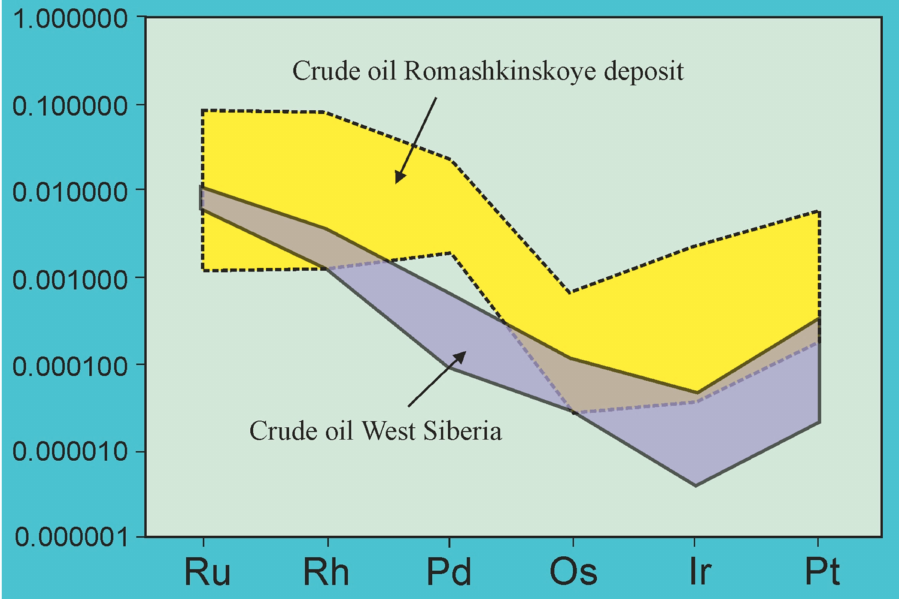
Figure 6. Distribution of platinoids in crude oils of the Romashkinskoye deposit and Western